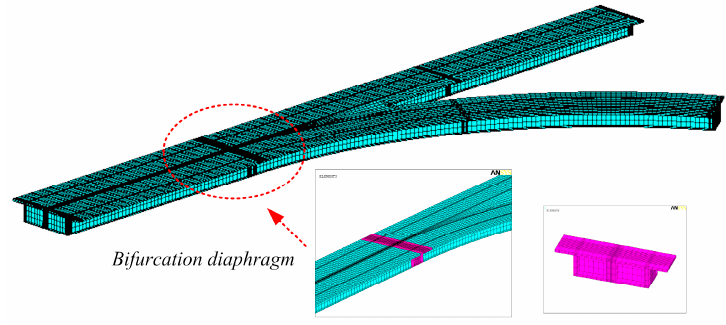
Figure 5. Finite element model of a typical irregularly-shaped bridge.